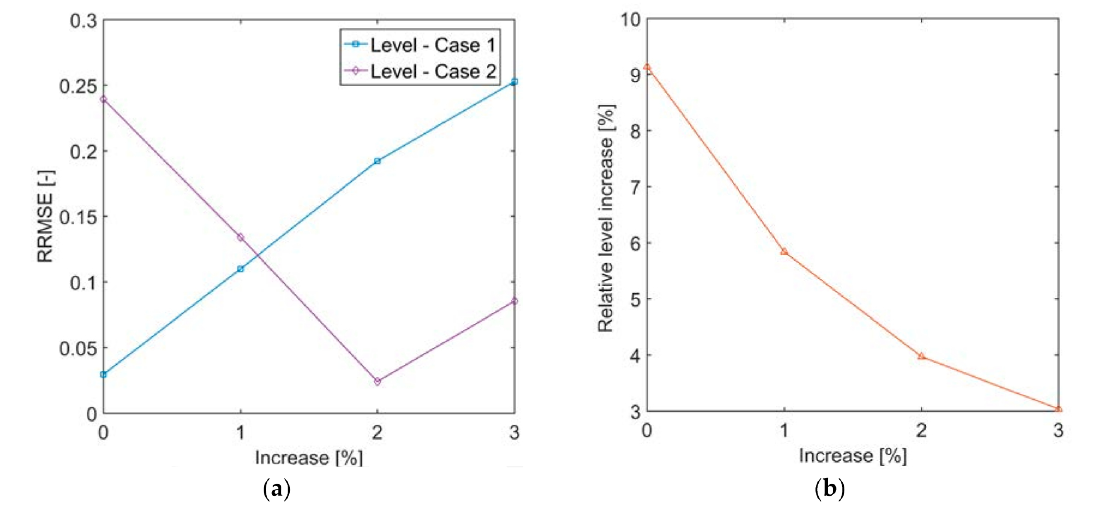
Figure 15. RRMSE for ( a ) the liquid level; and ( b ) relative level increase in Case